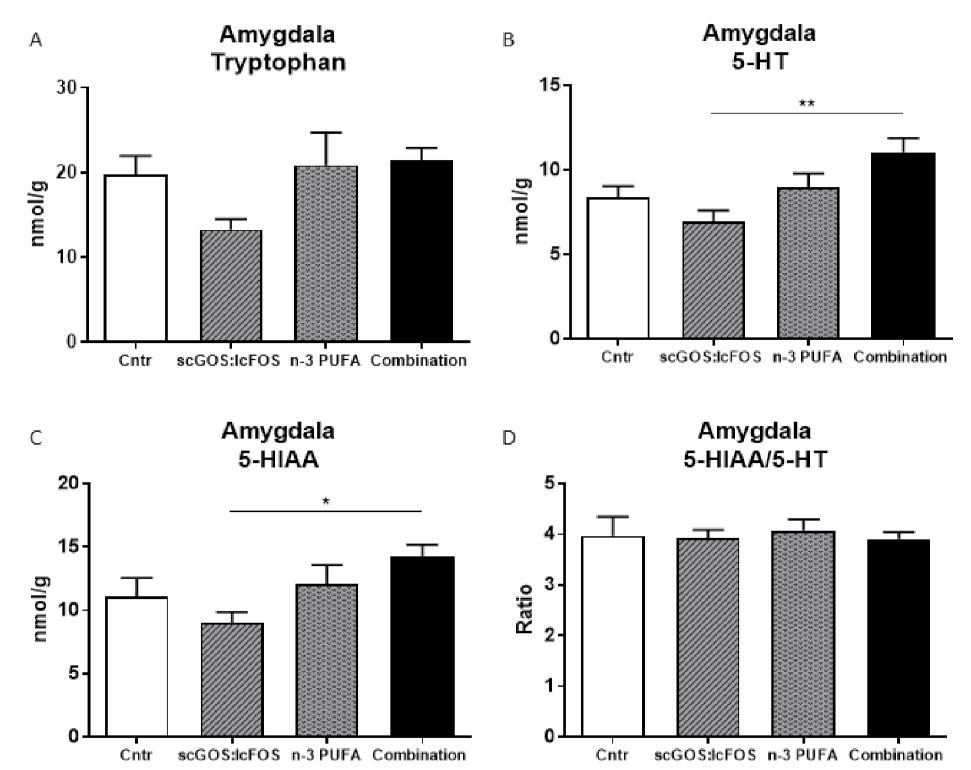
Figure 8. The amygdala levels of tryptophan, 5-HT, 5-HIAA and the serotonin turnover. ( A ) The tryptophan level did not differ between the dietary groups. ( B , C ) The 5-HT and 5-HIAA levels were significantly increased in the combination diet group compared to the scGOS:lcFOS group. ( D ) The serotonin turnover was unchanged in the dietary groups. ( A – D ): Data shown as the mean +/ − SEM. Analysed by one-way ANOVA and Sidak’s multiple comparisons post hoc test. * p < 0.05, ** p < 0.01. n = 4–5 samples per group, samples were pooled in pairs, in order to reach detection minimum, each sample contained two left brains. 5-HT: serotonin. 5-HIAA: 5-hydroxyindoleacetic acid (serotonin